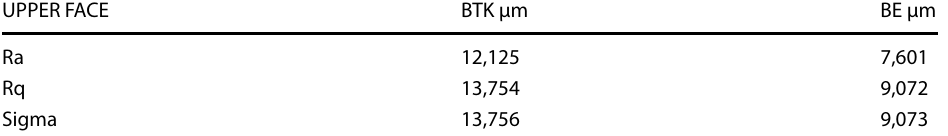
Table 2 Roughness parameters on upper faces of